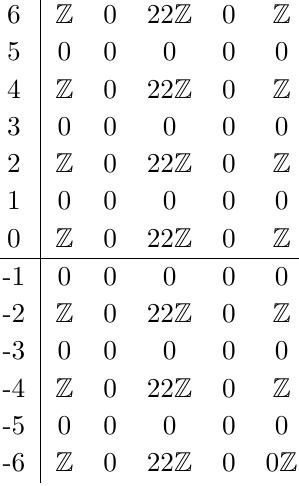
Table 16 . Second (and final) page of the AHSS for the computation of K − n ( K 3) .